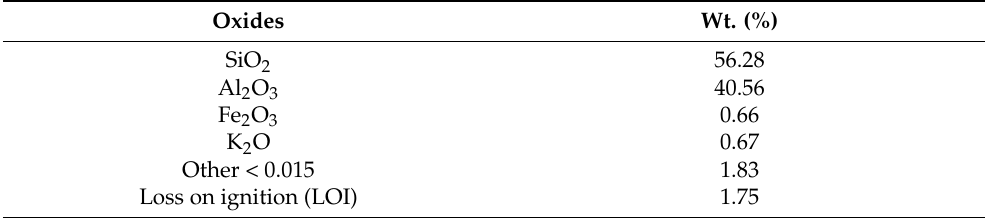
Table 2. Chemical composition of metakaolin.